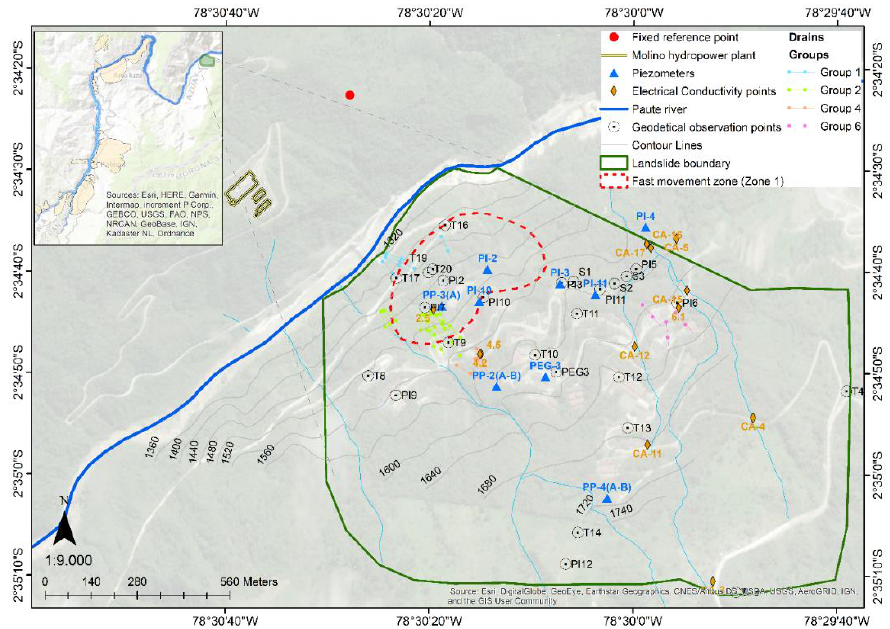
Figure 2. Instruments available in Guarumales and their location.